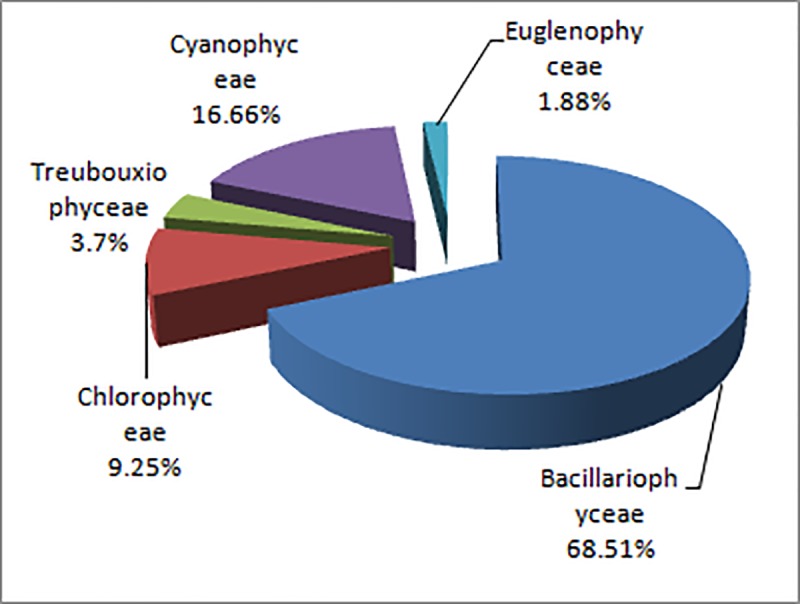
Compositions of algal group in the sampling stations.